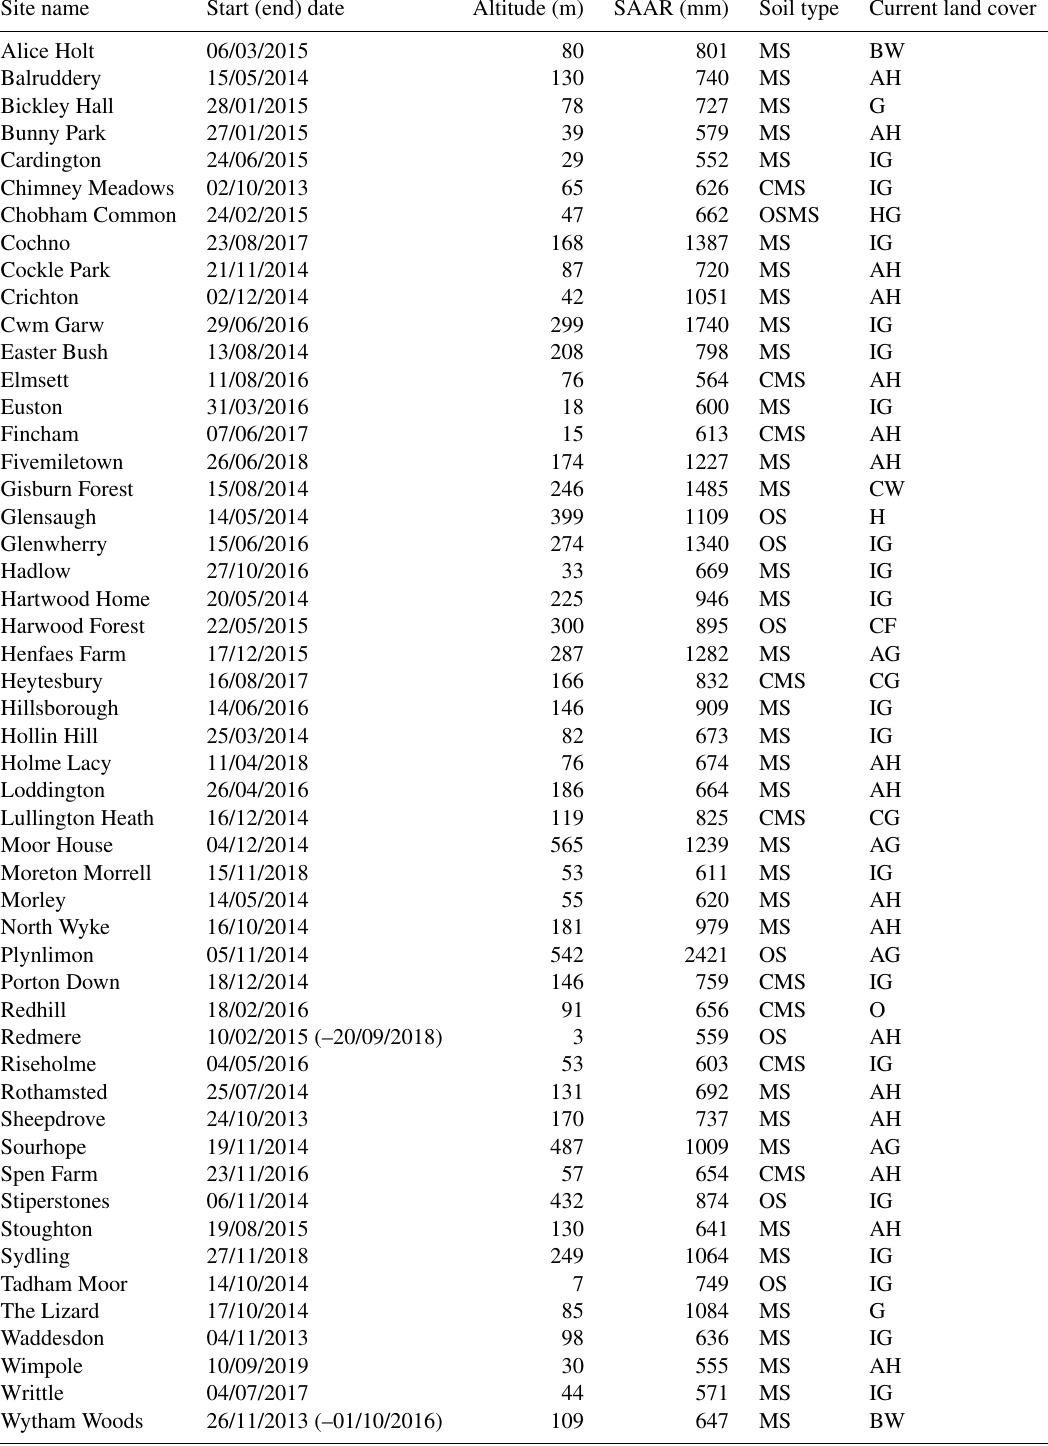
Table 1. Site information. Standard average annual rainfall (SAAR) is provided by the Flood Estimation Handbook (FEH) catchment descriptor SAAR6190 as described in Bayliss (1999). Monitored soil types include mineral soil (MS), calcareous mineral soil (CMS), organic soil (OS), and organic soil over mineral soil (OSMS). Land covers comprise broadleaf woodland (BW), coniferous woodland (CW), coniferous forest (CF), arable and horticulture (AH), grassland (G), improved grassland (IG), acid grassland (AG), calcareous grassland (CG), heather grassland (HG), heather (H), and orchard